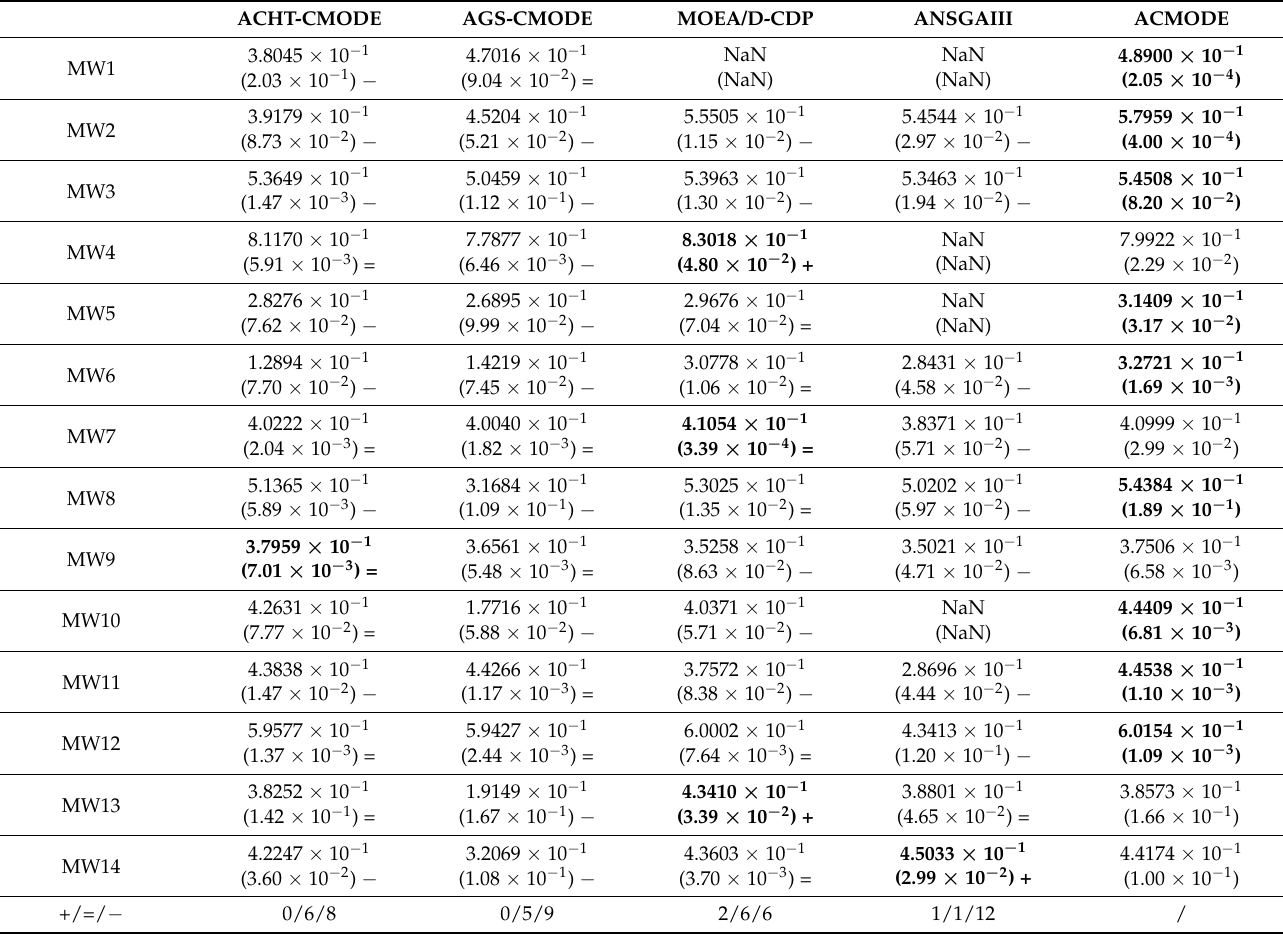
Table 9. HV results of all comparison algorithms on MW test